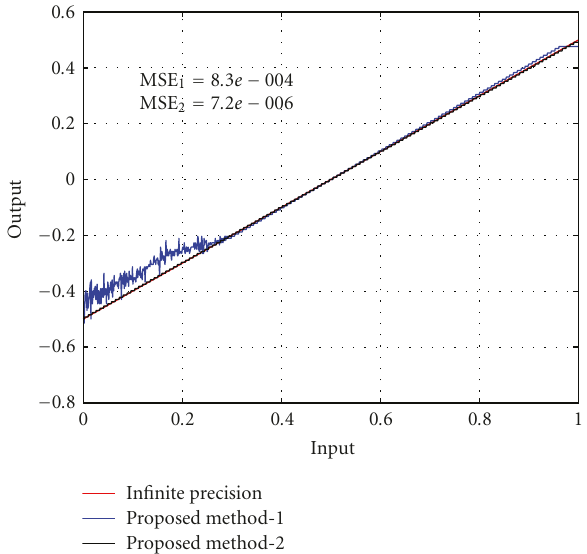
Figure 5: A comparison between the proposed ternary adders with DC ramp input, (red) infinite-precision, (blue) basic (method 1), and (black) improved (method